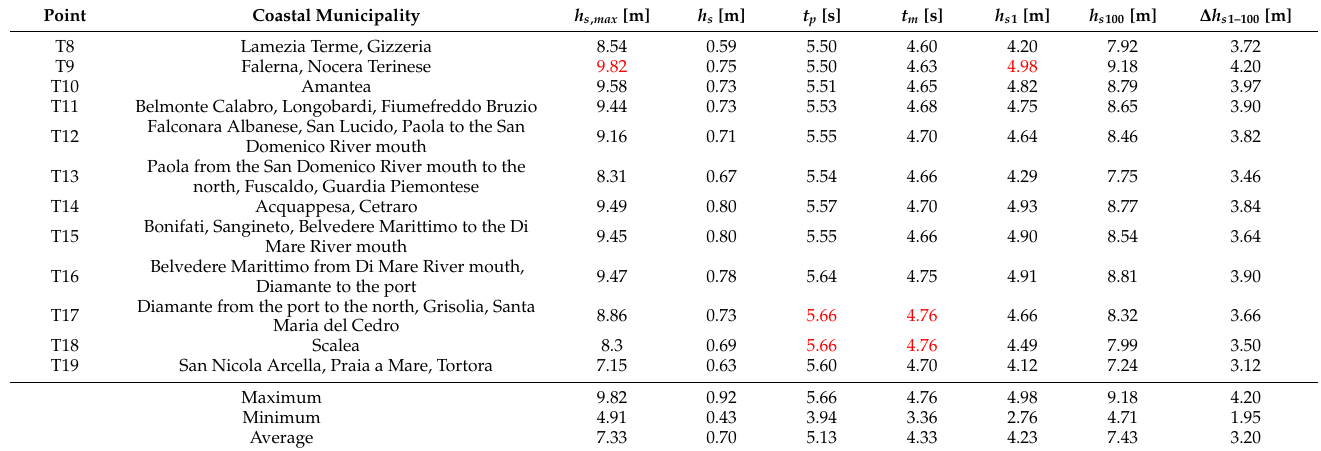
Table 2. Values of average annual energy flux Φ t , main MS , secondary SS , and tertiary TS sector